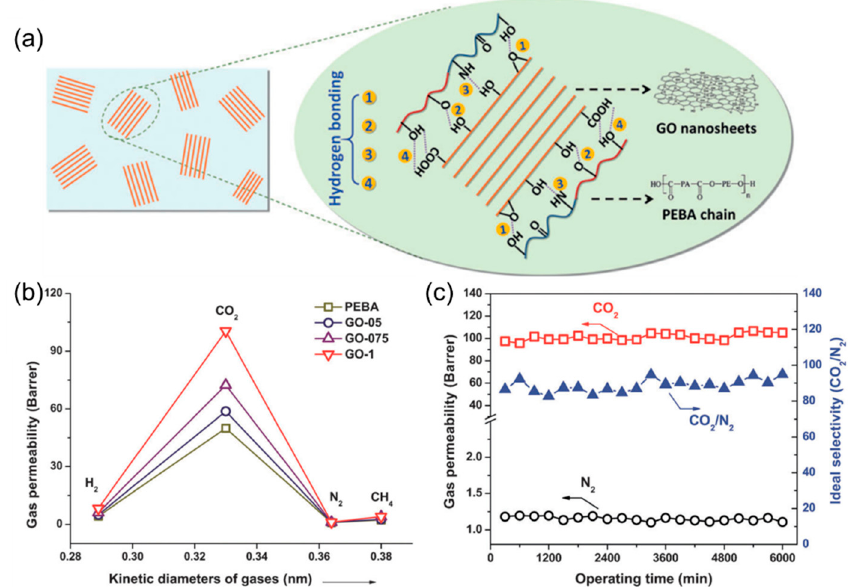
Figure 9. ( a ) Schematic of embedding GO nanosheets in PEBA. ( b ) The gas permeability of the MMMs with different GO loadings (0.05, 0.075, and 0.1 wt%). ( c ) Long-term stability test of an MMM containing 0.1 wt% GO for CO 2 /N 2 separation. Adapted with permission from [39]. John Wiley and Sons, Inc.